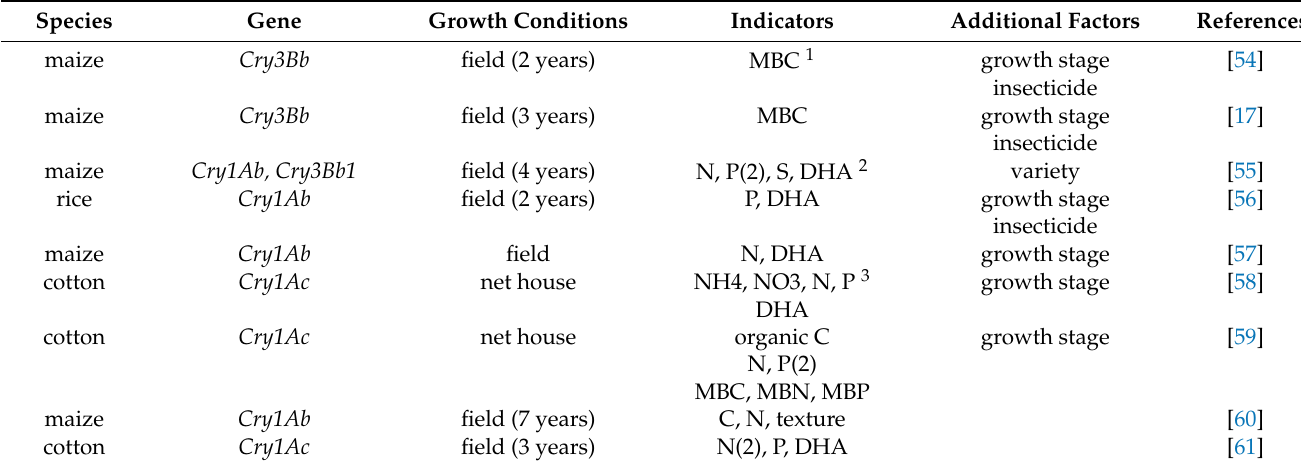
Table 1. Risk assessment of insect-resistant transgenic plants on soil